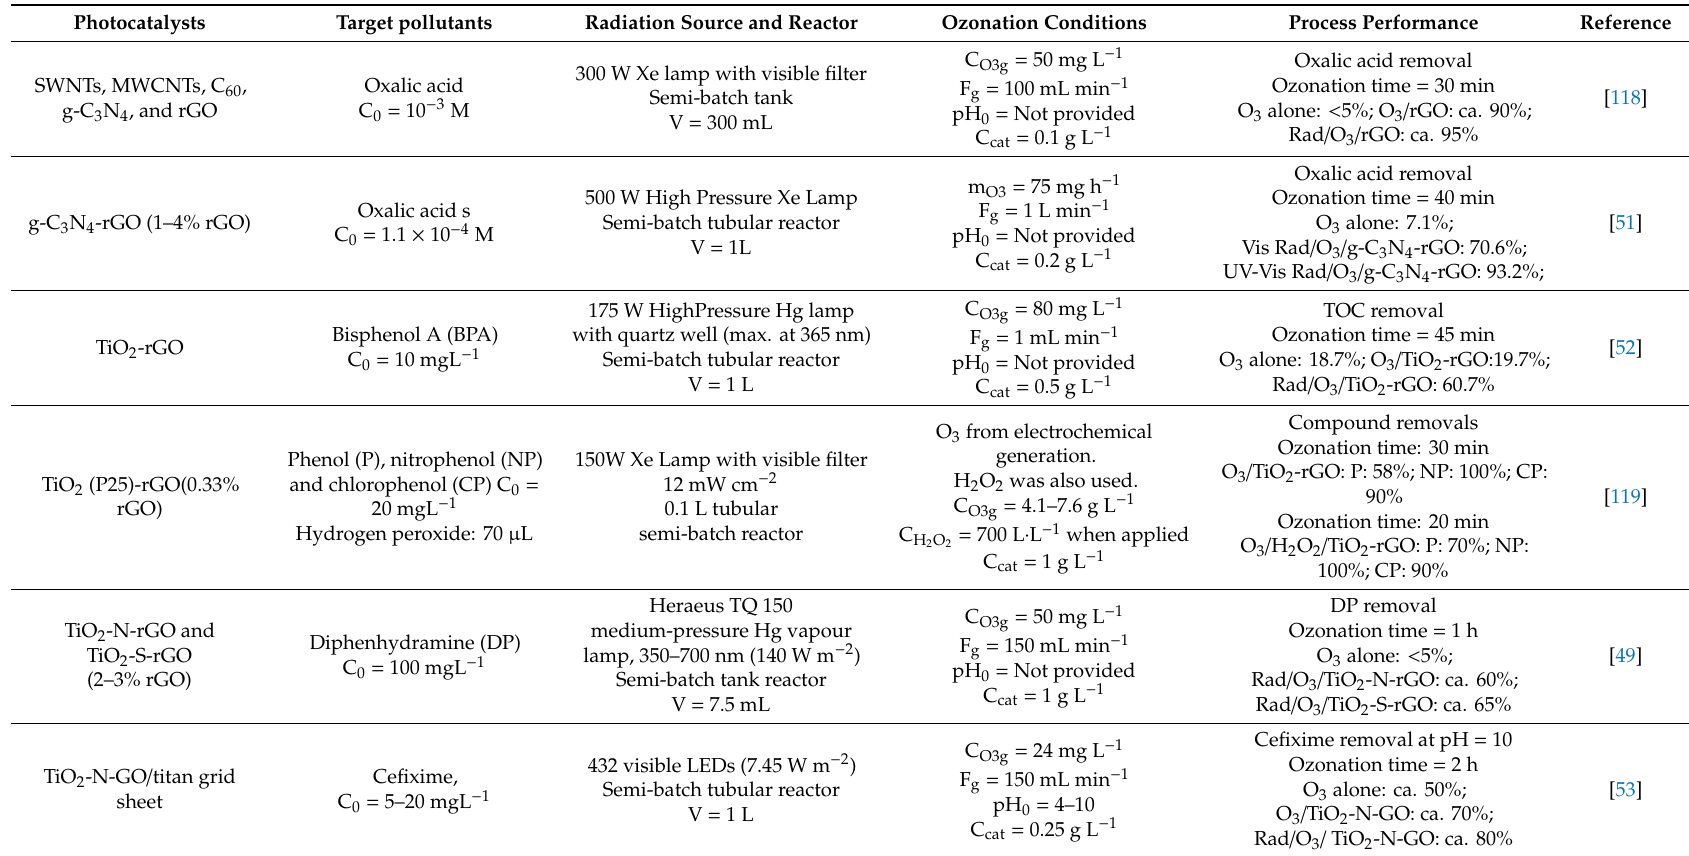
Table 3. Works on graphene-based catalysts used in photocatalytic